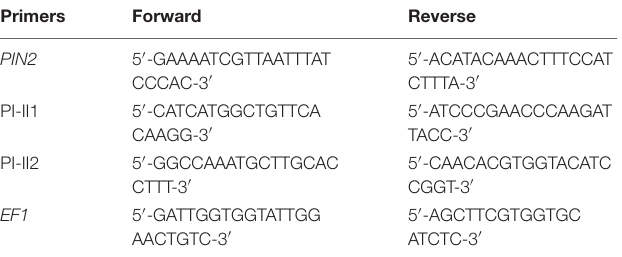
TABLE 1 | Forward and reverse sequences of PIN2 (Wound-induced proteinase inhibitor II precursor) marker gene for JA, PI-II1, and PI-II2 markers of plant proteinase inhibitor II, and the constitutive gene EF1. Primers